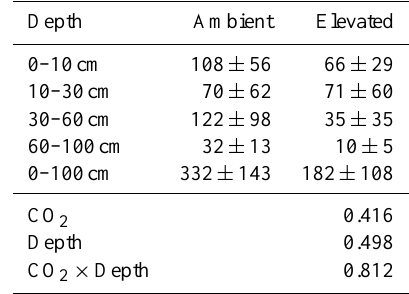
Table 2. Nodule mass (gm − 2 ) recovered in soil cores at the final harvest in 2007. P values from split-plot ANOVA are shown in the last three rows.